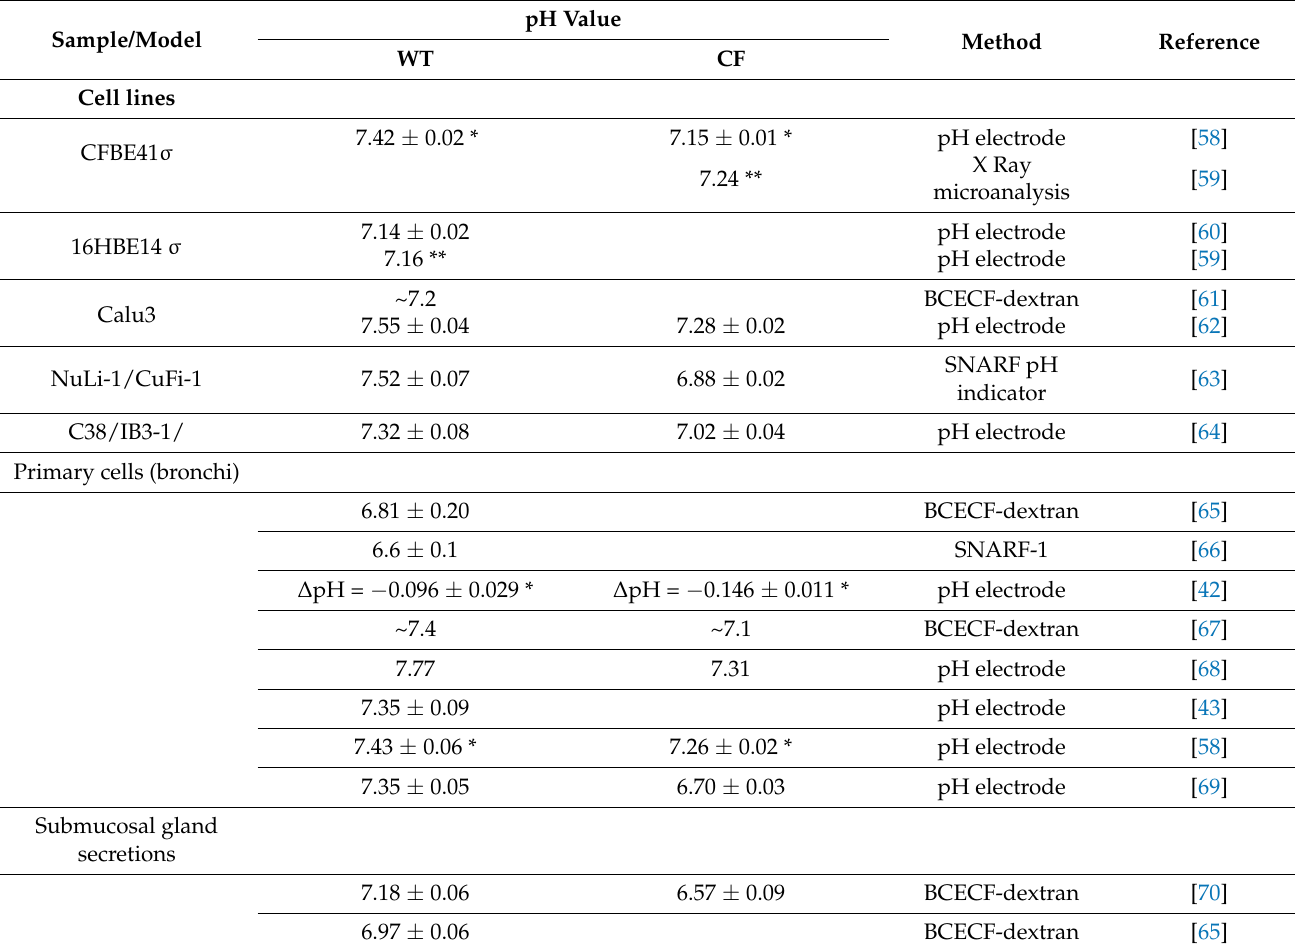
Table 2. ASL pH in vitro measurements of human